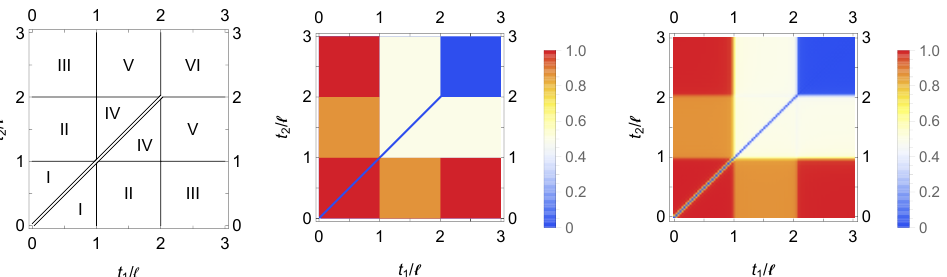
Figure 8 . Local operator quench inside the subsystem A = [0 ; 3 ‘ ] at x = ‘ . Left: the division of the ( t 1 ; t 2 ) plane according to the positions of the quasiparticles. Middle: the CFT result of the second Schatten distance (4.5) with n = 2 ; q = 1 . Right: the numerical result of the second 2 Schatten distance for the inserted operator d 2 j (cid:0) 1 in the linearized critical Ising spin chain (with ‘ = 32, i.e. with an interval length 3 ‘ =